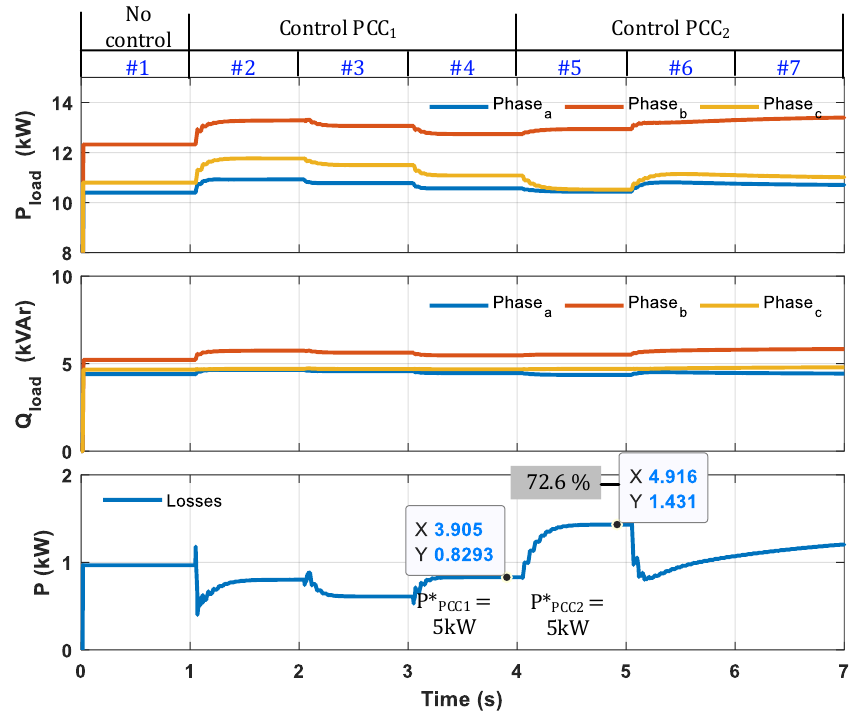
Figure 9. Active/reactive power of the load and losses in µG.